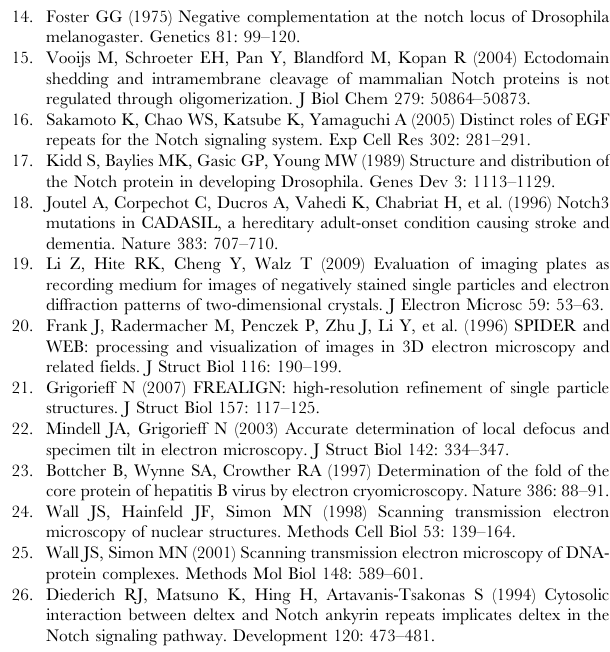
Table S1 3D reconstructions.